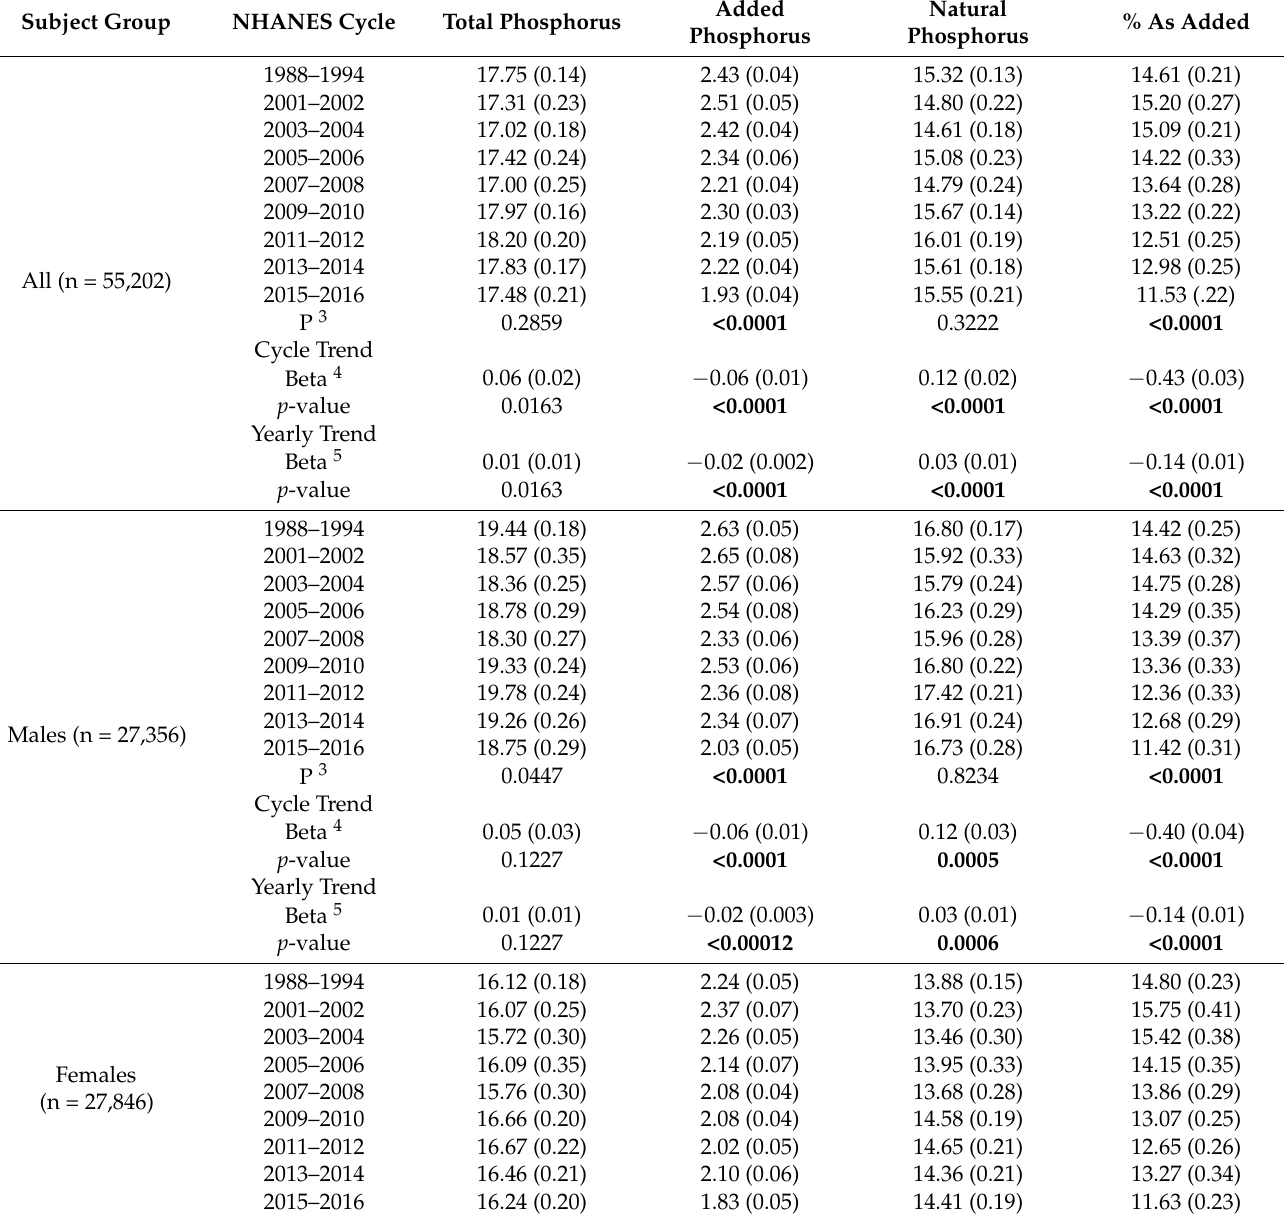
Table 2. Daily total, added, and natural phosphorus mean 1,2 intake per body weight (mg/kg) and percentage of total phosphorus as added for adults 19 years of age and older, the NHANES 1988–1994 and